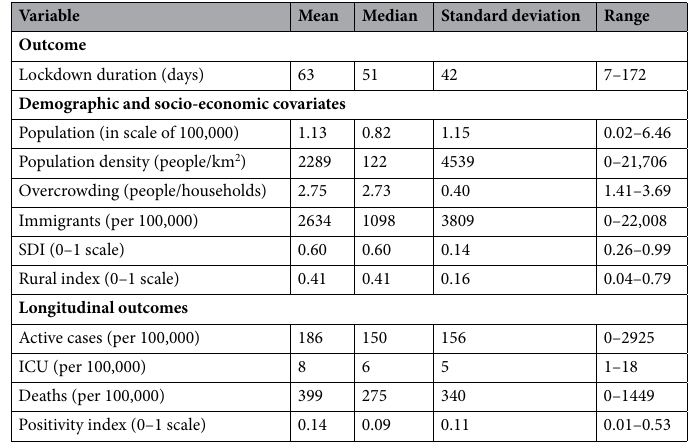
Table 1. Descriptive statistics of outcome and covariates considered in the model building process for the 147 communes included in the study (N = 166). SDI socioeconomic development index, ICU intensive care units.